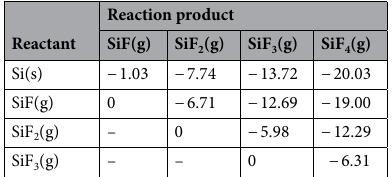
Table 1. The reaction enthalpies, measured in electronvolts, at standard